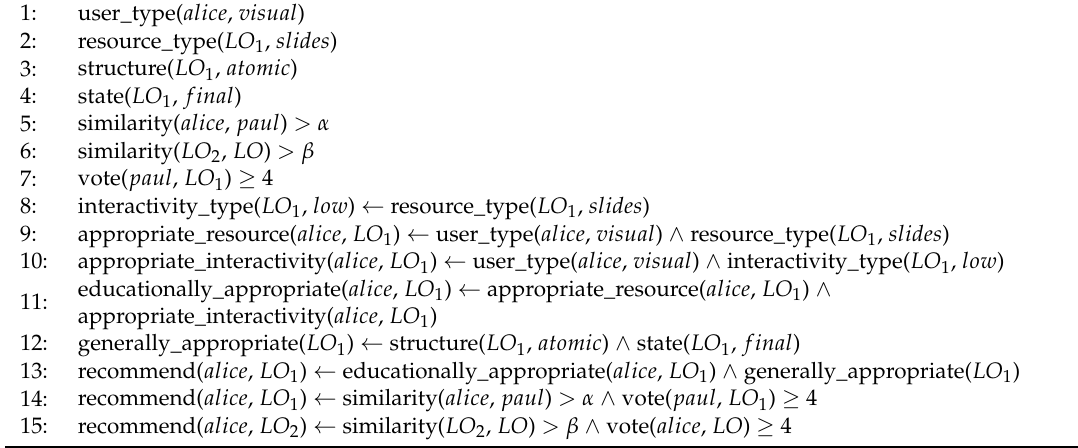
Table 1. Example logic program.